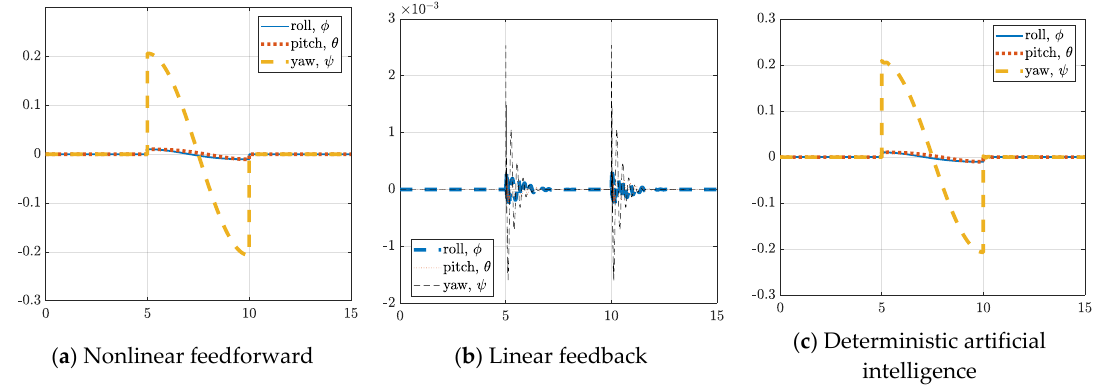
Figure 6. Control (Newton-meters) versus time in seconds for the three configurations. Table 2. Actual desired Euler angle errors and associated run times for the three cases 1